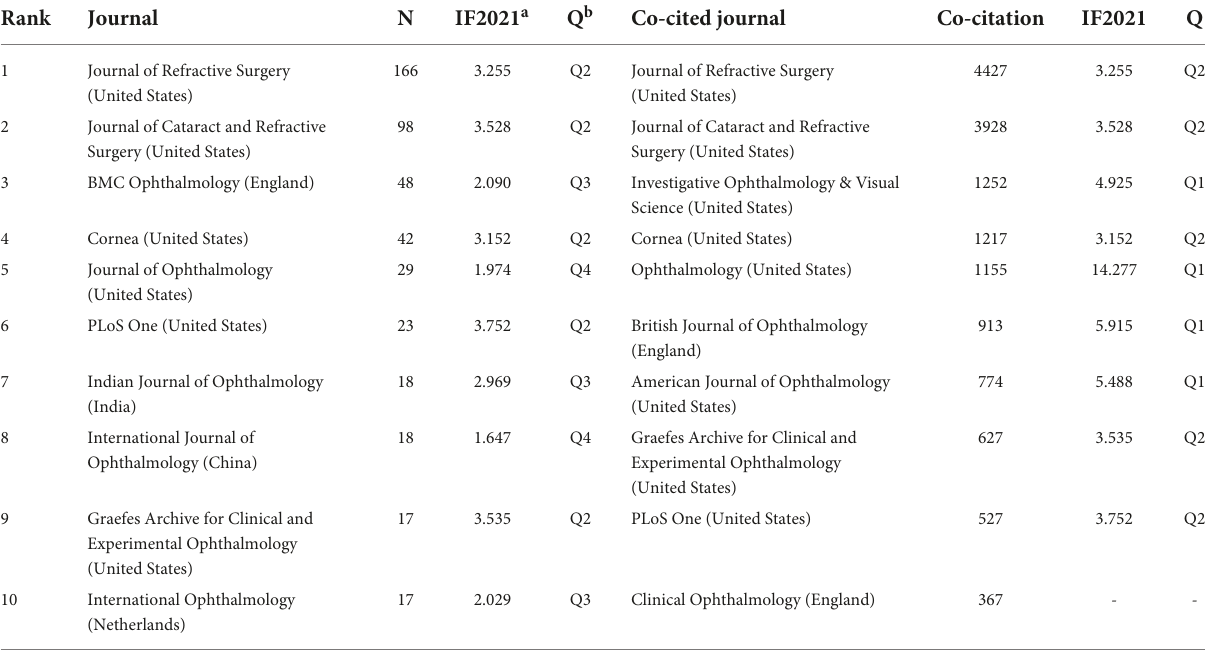
TABLE 2 The top 10 productive journals and co-cited journals of SMILE